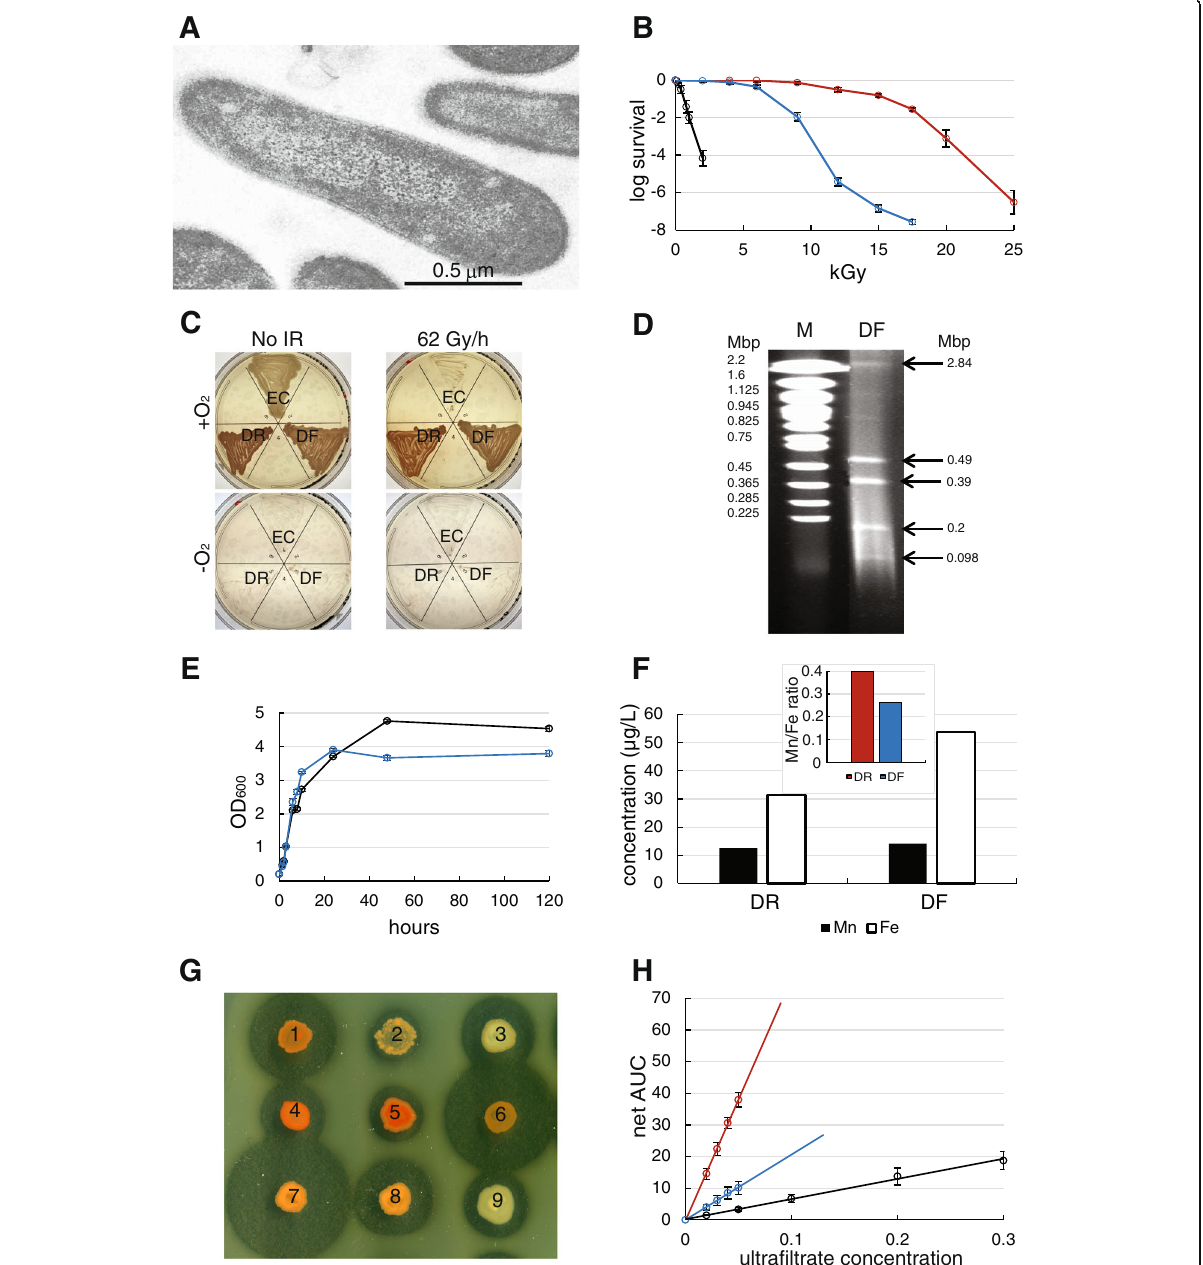
Fig. 2 Deinococcus ficus KS 0460 (EXB L-1957) phenotype. a Transmission electron micrograph. D. ficus grown in TGY, early-stationary phase. b Survival of D. radiodurans BAA-816 (red), D. ficus ( blue ), and E. coli (strain K-12, MG1655) ( black ) exposed to acute IR. The indicated strains were inoculated in liquid TGY and grown to OD 600 ~ 0.9. Cells were then irradiated on ice with Co-60. c D. ficus is an aerobe capable of growth under 62 Gy/h. DR, D. radiodurans ; DF, D. ficus ; EC, E. coli . d PFGE of genome partitions in a 0.9% agarose gel. PFGE conditions: 0.5 × TBE, 6 V/cm with a 10 to 100 s switch time ramp at an included angle of 120°, 14 °C, 18 h. M, marker S. cerevisiae YNN (BioRad). e Growth curves at 37 °C ( blue ) and 32 °C ( black ) in TGY medium. f ICP-MS on Mn and Fe content of D. radiodurans BAA-816 and D. ficus . Inset: Mn/Fe ratios. g Protease secretion assay. Halos indicate activity of proteases [60]. Strains: 1. D. radiodurans BAA-816, 2. D. geothermalis DSM 11300, 3. D. ficus KS 0460, 4. D. murrayi (MD591), 5. D. radiopugnans (MD567), 6. D. radiodurans (MD878, SX-108-7B-1, [61]), 7. D. proteolyticus (MD568), 8. D. proteolyticus (MD628, [62]), and 9. D. proteolyticus (MD869). h Antioxidant capacities of D. radiodurans BAA-816 ( red ), D. ficus ( blue ), and E. coli (strain K-12, MG1655) ( black ) ultrafiltrates assessed by antioxidant assay as described previously [63, 64]. Net AUC is an integrative value of a total fluorescence during antioxidant reaction in the presence of